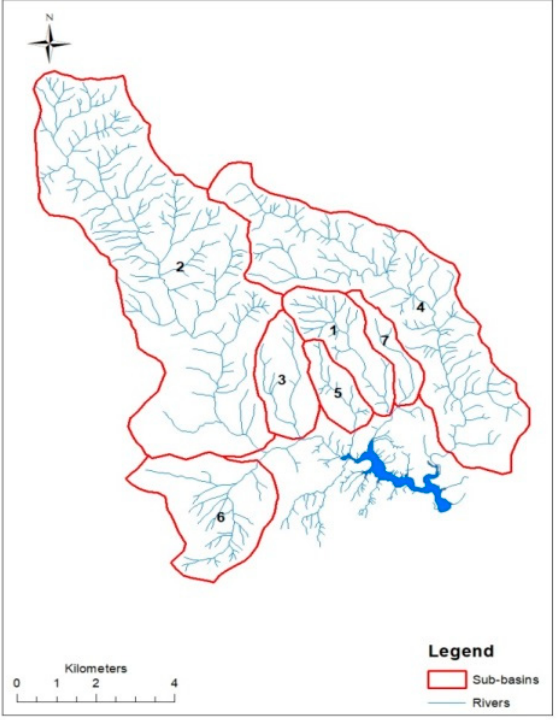
Figure 4. Sub-basins of study area.